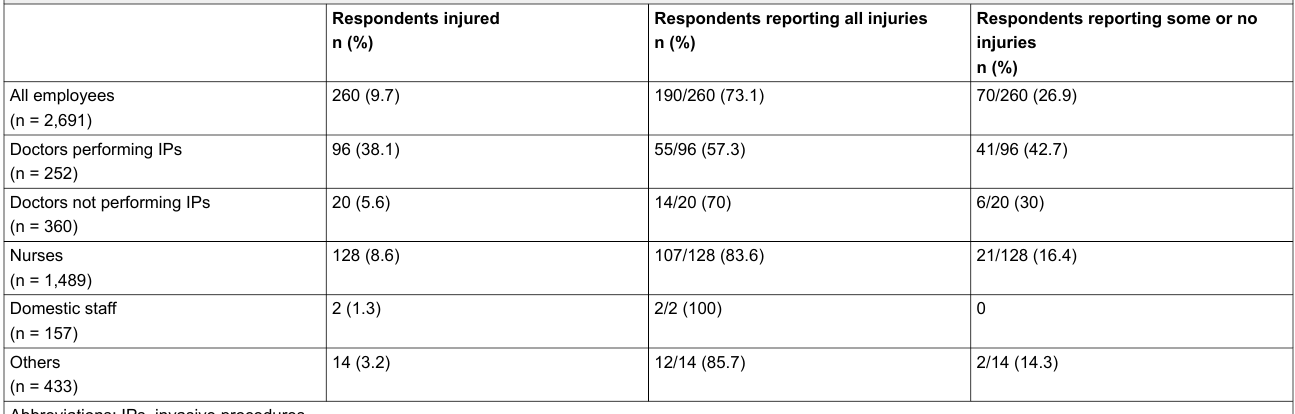
Table 3: Rate of needlestick and sharps injury (NSSI) per occupation and proportion of NSSIs reported or not reported to the occupation health service.